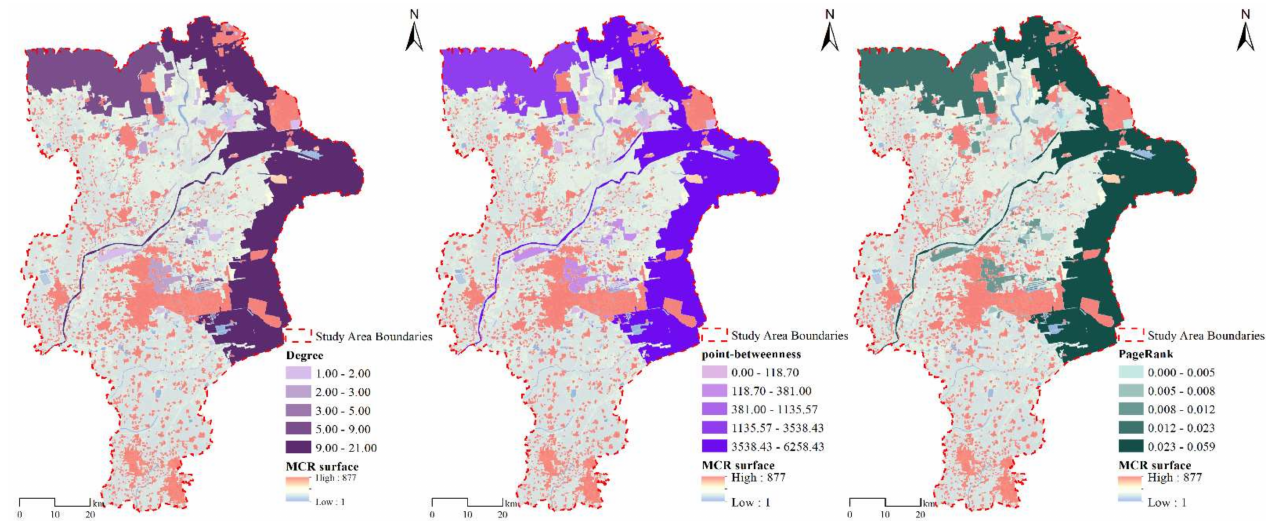
Figure 7. Distribution of degree ( left ), point-betweenness ( middle ), and PageRank ( right ) in Dongy- ing